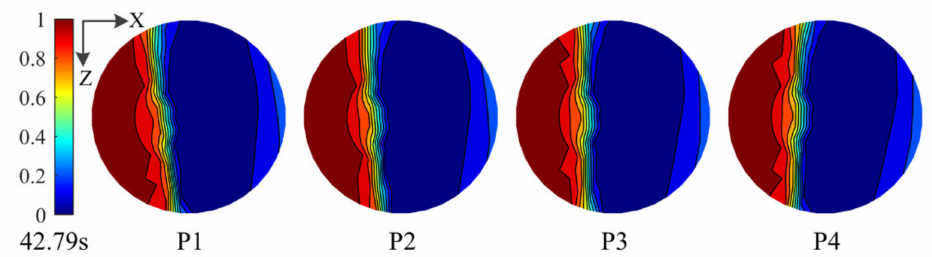
Figure 21. The compression damage of concrete in the core area at 42.79 s.